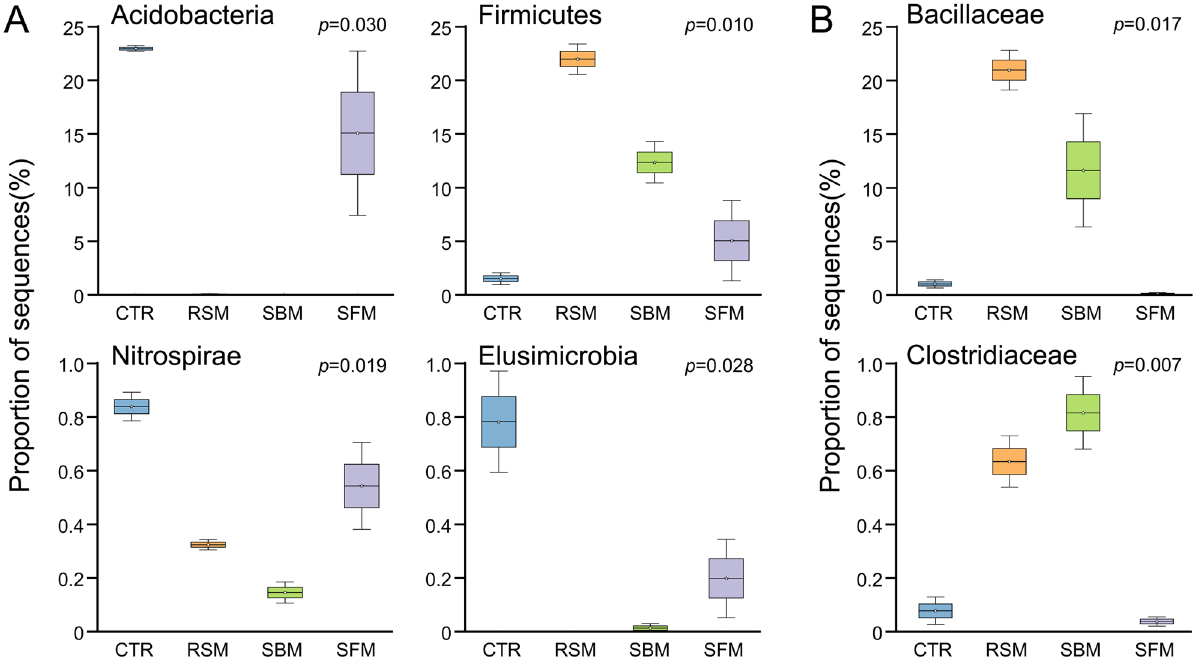
Figure 3. Relative proportion of sequences ( y -axis) derived from the NGS data, in digesta samples of European sea bass fed the experimental diets for 45 days ( x -axis): CTR, control fishmeal based diet; SBM, soybean meal based diet; RSM, rapeseed meal based diet; SFM, sunflower meal. Incorporation of SBM and RSM diminishes the Acidobacteria ( p = 0.030), Elusimicrobia ( p = 0.028) and Nitrospirae ( p = 0.010) phyla. On contrary, SBM and RSM PF-based diets favor the Firmicutes ( p = 0.01), in particular the Bacillaceae ( p = 0.017) and Clostridiaceae ( p = 0.007). essential to fully evaluate current aquaculture feeding strategies. This theme has been recently addressed, through high-throughput sequencing, in a few carnivorous aquaculture fish species, mainly in the salmonids Atlantic